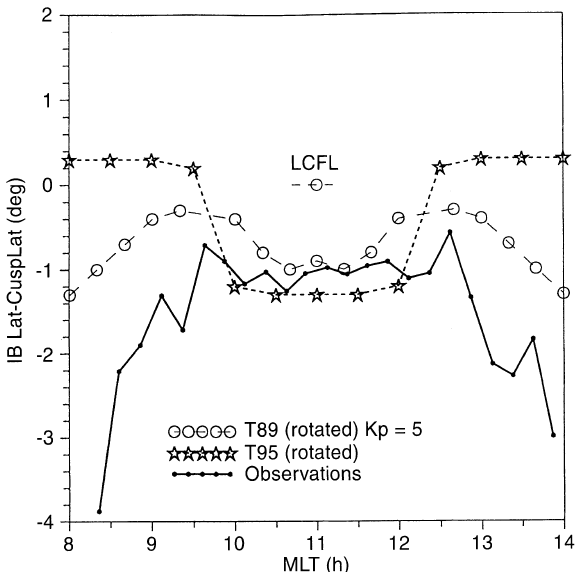
Fig. 11. Same as Fig. 4, but with overlapping modeled isotropic boundaries (for zero dipole tilt) and average observed isotropic boundary. Modeled IBs are here shifted by 1 h MLT toward earlier time to facilitate comparison with observations. The observed IB is taken from Fig. 8 but the expected latitude of the last closed field line at noon is subtracted (distance between LCFL and IB was taken to be 1 (cid:176) CGLatitude according to the results of